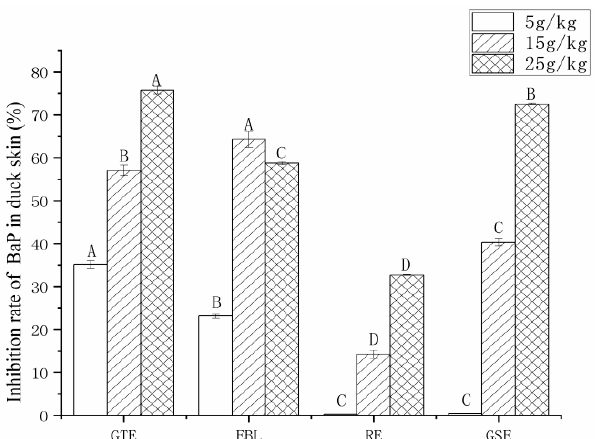
Figure 5. Contents of BaP in roast duck skin treated with four different extracts and three levels of addition. Note: GTE: pickling solution with green tea extract; EBL: pickling solution with extract of bamboo leaves; GSE: pickling solution with grape seed extract; RE: pickling solution with rosemary extract. Different letters (A, B, C and D) indicate significant differences comparison among extracts ( p < 0.05).